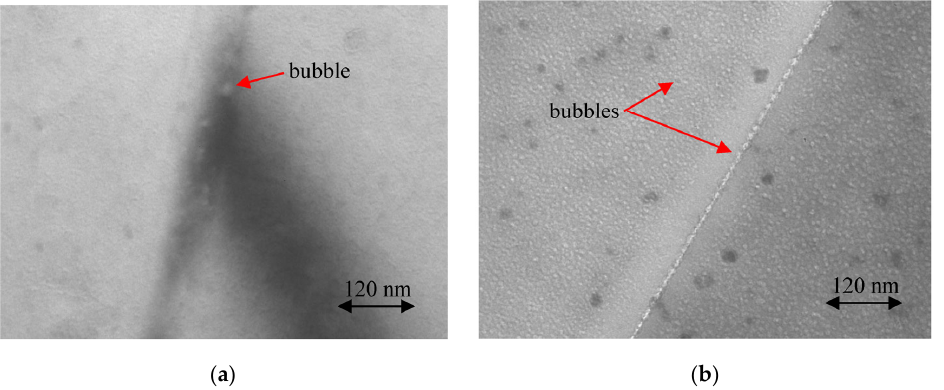
Figure 8. Small helium bubbles in microstructure of HE ‐ 56 beryllium grade irradiated at 70 °C ( a ) and 200 °C ( b ) to neutron fluences of 7 ∙ 10 22 cm − 2 (E > 1 MeV) and 6.5 ∙ 10 22 cm − 2 (E > 1 MeV), accordingly (transmission electron microscopy).